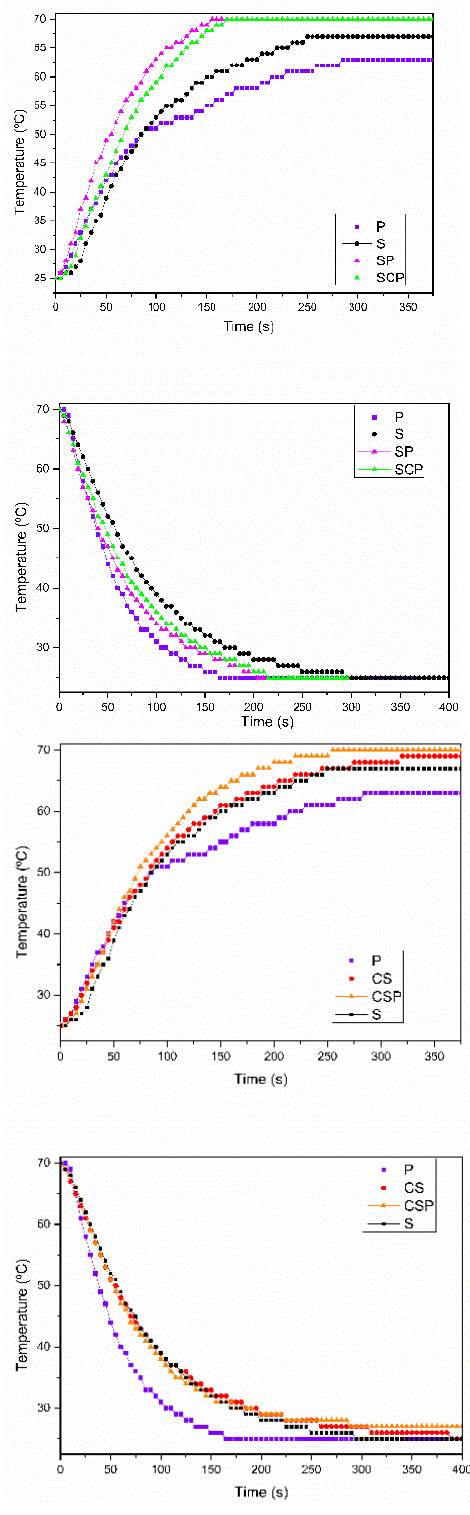
Figure 6. The heating ( top ) and cooling curves ( bottom ) of paraffin, saponite and PCMs. The curves for paraffin and saponite have been repeated for comparison purposes.